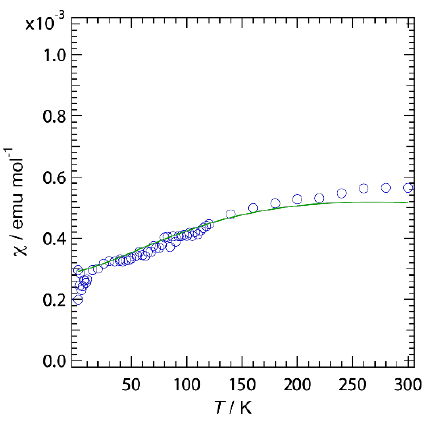
Figure 5. Temperature dependence of magnetic susceptibility of 3 . The green solid line is calculated on the basis of a 1D Heisenberg model.